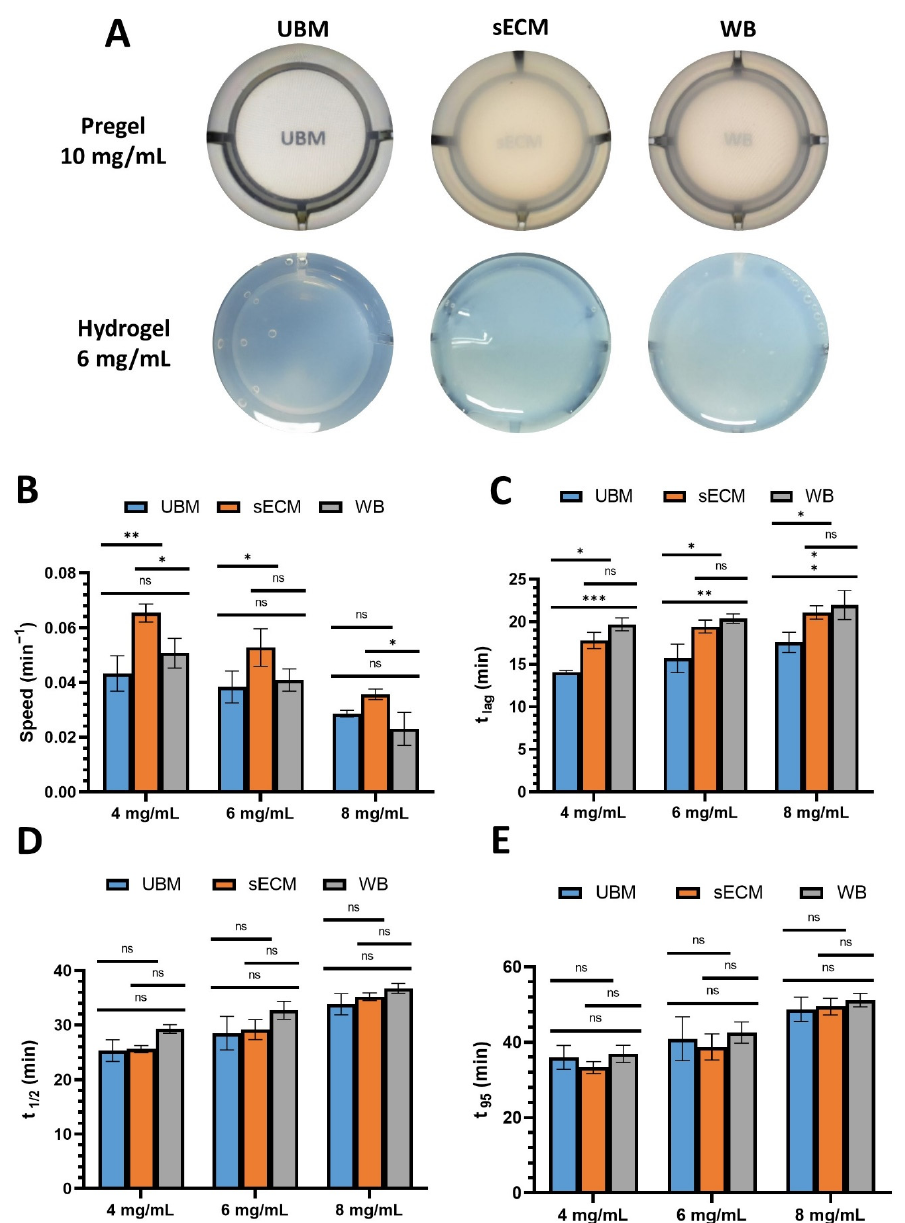
Figure 2. Difference in transparency of the pregel solution and hydrogel from different tissue source of the bladder ( A ). Gelation speed ( B ), t lag ( C ) and t 1/2 ( D ) and t 95 ( E ) of the hydrogels. *, **, *** denote statistical difference within the same group with p < 0.05, 0.01, 0.001, respectively ( n = 3).